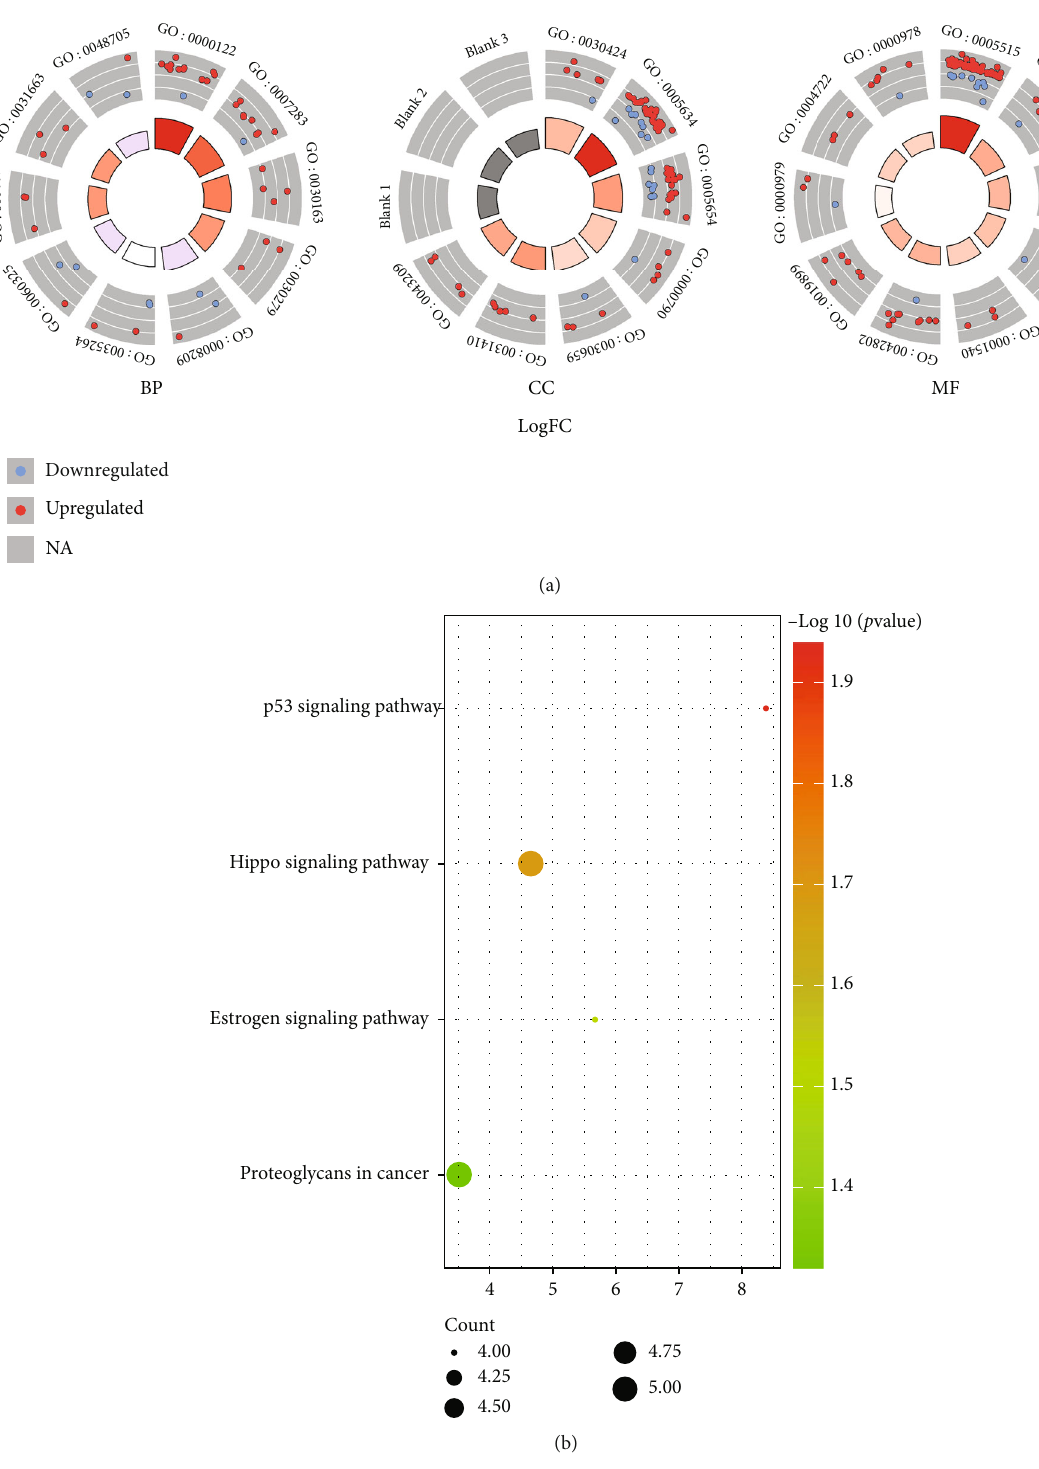
Figure 4: Results of GO and KEGG enrichment analysis. (a) GOCircle plot of GO enrichment analysis. (b) GOBubble plot of KEGG enrichment